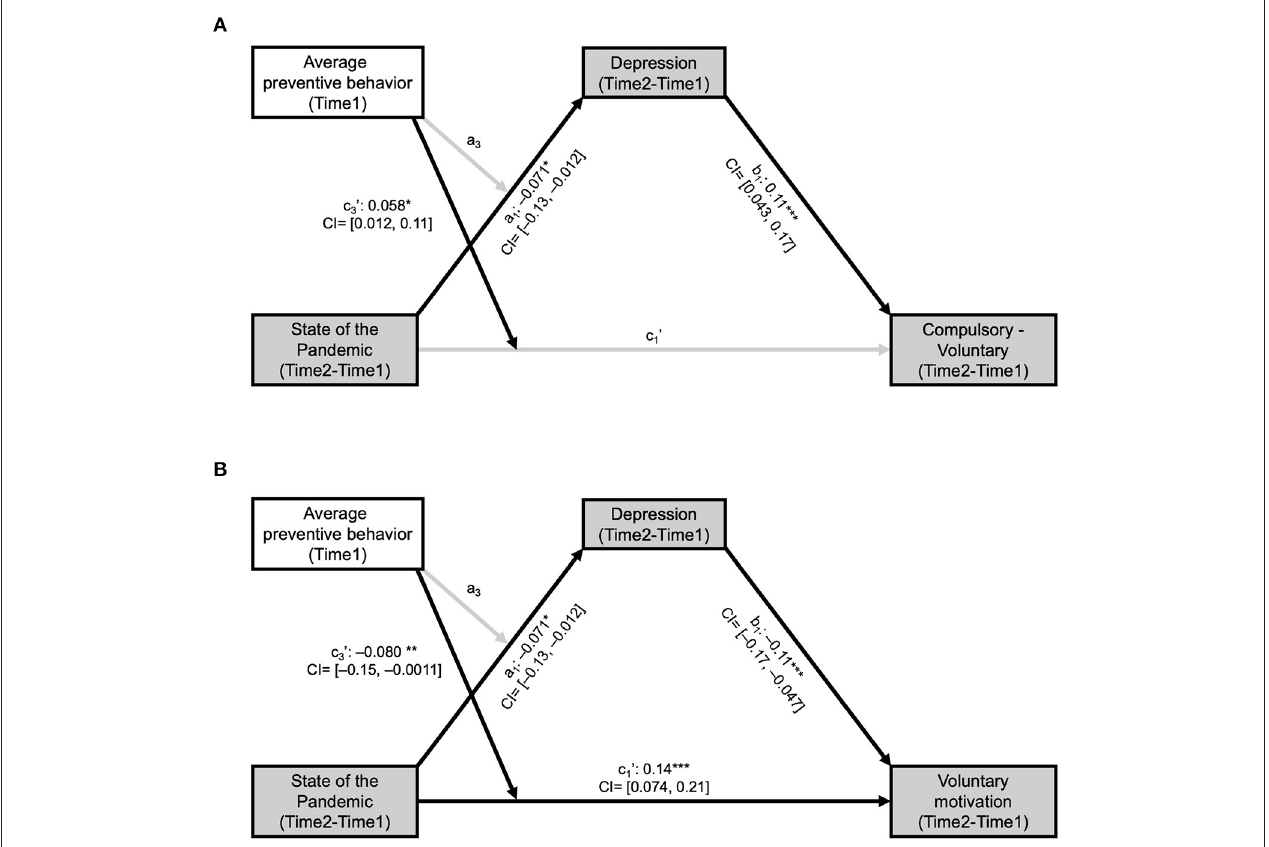
FIGURE 4 | Changes in depressive symptoms mediated the inconsistency between belief about the COVID-19 pandemic state and voluntary motives to follow prevention measures. (A) To examine the moderated mediation effect of change in depressive symptoms, we set to change in belief about the COVID-19 pandemic state (negative score for Time 2—Time 1 indicates “pandemic got worse”) as a predictor, the average tendency of individuals to follow preventive behaviors (e.g., wearing masks) as a moderator, and compulsory vs. voluntary motives to follow prevention measures as an outcome variable. Change in depressive symptoms between Time 1 and Time 2 was significantly associated with both change in belief about the COVID-19 pandemic state (a 1 : t = − 2.40, P = 0.016) and average tendency to follow preventive behavior before Time 1 (a 2 : t = 2.38, P = 0.017; path not depicted). Individuals with increased depressive symptoms showed greater increase in compulsory than voluntary motives [compulsory(Time 2)—voluntary(Time 2)]—[compulsory(Time 1)—voluntary(Time 1)] (b 1 : t = 3.66, P = 0.00026). After adjusting for the mediation effect of the depressive symptoms of individuals, the direct effects from the belief change and preventive behavior to the motivational change were not significant (c 1 ’: t = − 0.25, P = 0.80, c 2 ’: t = 0.31, P = 0.76; c 2 ’ path not depicted). Nevertheless, the interaction between the belief change and the average tendency to follow preventive behavior on the motivational change was significant (c 3 ’: t = 2.32, P = 0.021). (B) Particularly, individuals with increased depressive symptoms showed a greater decrease in voluntary motives (b 1 : t = − 3.72, P = 0.00021). After adjusting for the mediation effect of the depressive symptoms of individuals, the direct effects of the belief change (c 1 ’: t = 4.88, P < 0.000010) and average tendency to follow preventive behavior (c 2 ’: t = − 3.48, P = 0.00051; path not depicted) were both significant. The interaction effect between the two predictors on the changes of voluntary motives was significant (c 3 ’: t = − 3.29, P = 0.0011) but was not significant on the change in depressive symptoms (a = − 0.087, P = 0.93). Black and gray arrows indicate significant and non-significant associations between the components, respectively. * P < 0.05, ** P < 0.005, *** P < 0.001; CI: 95% bootstrap confidence interval for each of the standardized beta